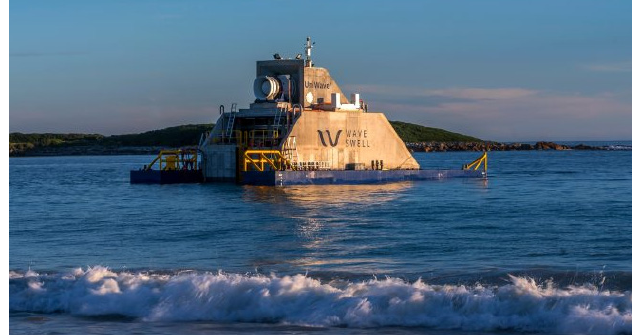
Figure 15. Wave Swell (King Island, Australia) [57].